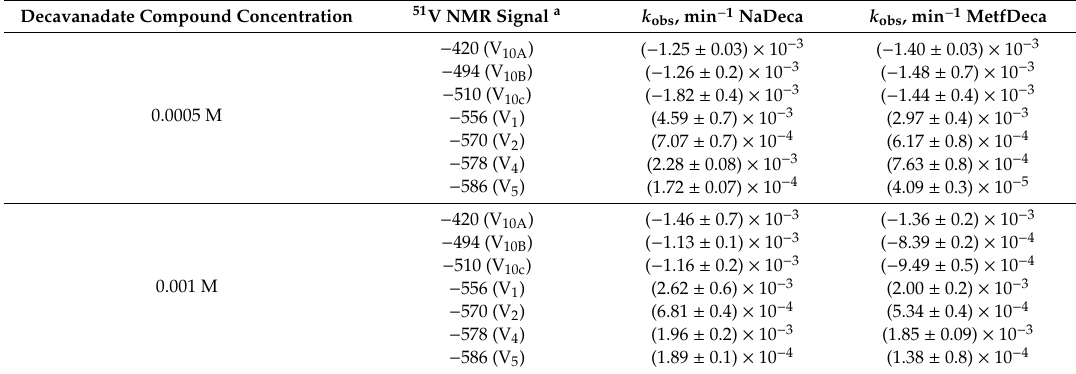
Table 1. Summary of rate constants for the decomposition of 0.5 and 1.0 mM NaDeca and MetfDeca compound hydrolysis in DMEM medium at 25 ◦ C and pH